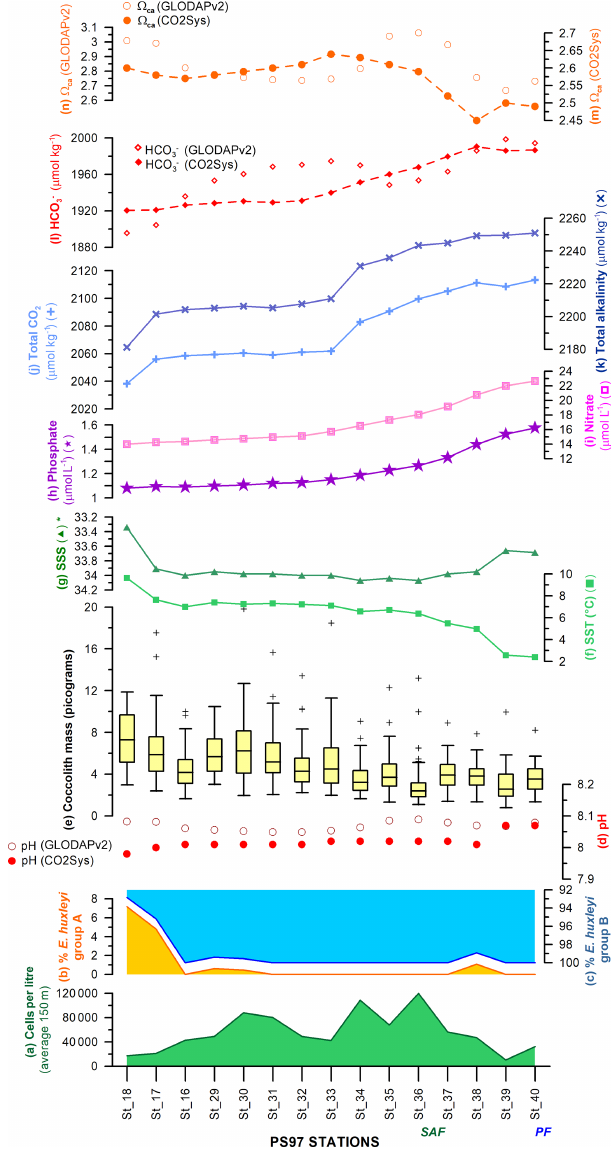
Figure 12. Latitudinal transect showing, on the left-hand side, (a) the uppermost 150m average of cells per litre, relative abun- dance of E. huxleyi morphotypes belonging to (b) group A and (c) group B, (d) pH calculated with different approaches (Pierrot et al., 2006; Key et al., 2015), (e) coccolith mass box plot (out- liers are indicated with “ + ”), (f) sea-surface temperature (SST; ◦ C), and (g) salinity ( ∗ note the inverted scale) measured in situ (Lamy, 2016). Interpolated (h) phosphate (µmolL − 1 ) and (i) ni- trate contents (µmolL − 1 ; Garcia et al., 2014), (j) total alkalinity (µmolkg − 1 ) and (k) total CO 2 (µmolkg − 1 ; Goyet et al., 2000), (l) bicarbonate ion (HCO − , µmolkg − 1 ), and (m) calcite satura- 3 tion state ( (cid:127) Ca ) calculated with different approaches (Pierrot et al., 2006; Key et al., 2015). The Subantarctic Front (SAF) and Polar Front (PF), according to Orsi et al. (1995), are